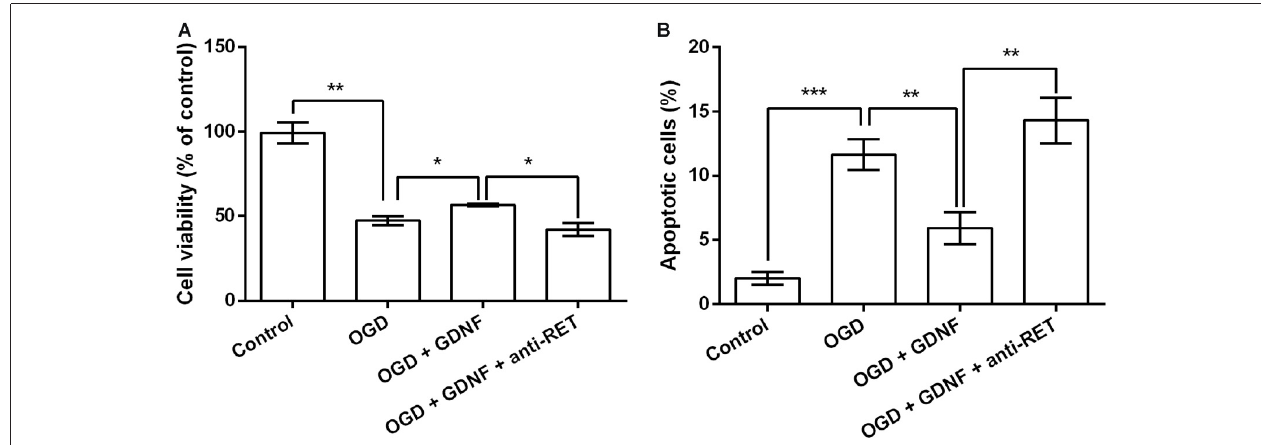
FIGURE 4 | GDNF prevents OGD-induced neuronal injury. (A) Neuronal viability is promoted by pretreatment with GDNF before OGD, but is suppressed by anti-RET antibody treatment. (B) Neuronal apoptosis is reduced by GDNF pretreatment before OGD, but is improved by anti-RET antibody treatment. ∗ P < 0.05. ∗∗ P < 0.01. ∗∗∗ P <